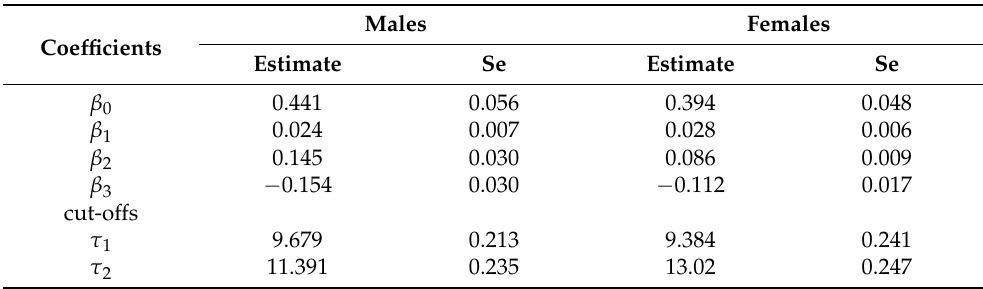
Table 1. Parameter estimates of the segmented regression model (1) were used to fit the data separately for males and